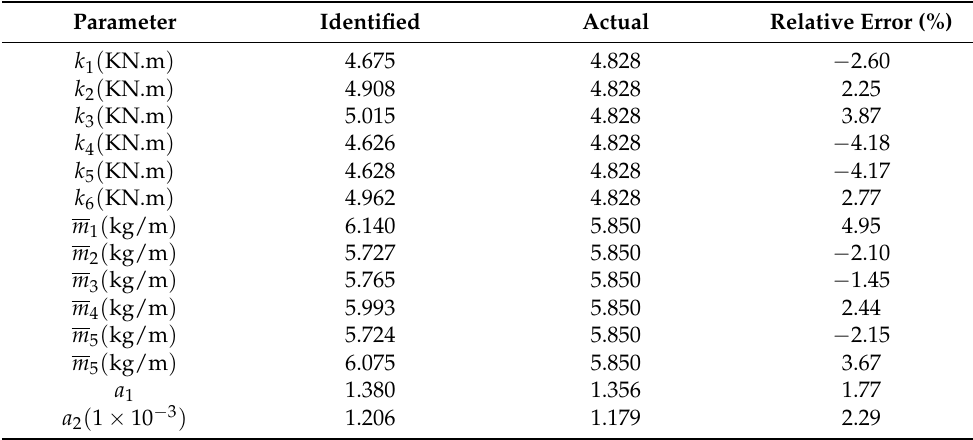
results meet the accuracy requirements; the relative error of the identified mass, stiffness and damping coefficients relative to their true value is less than 5%. Table 1. The parameters identification results of the simply supported